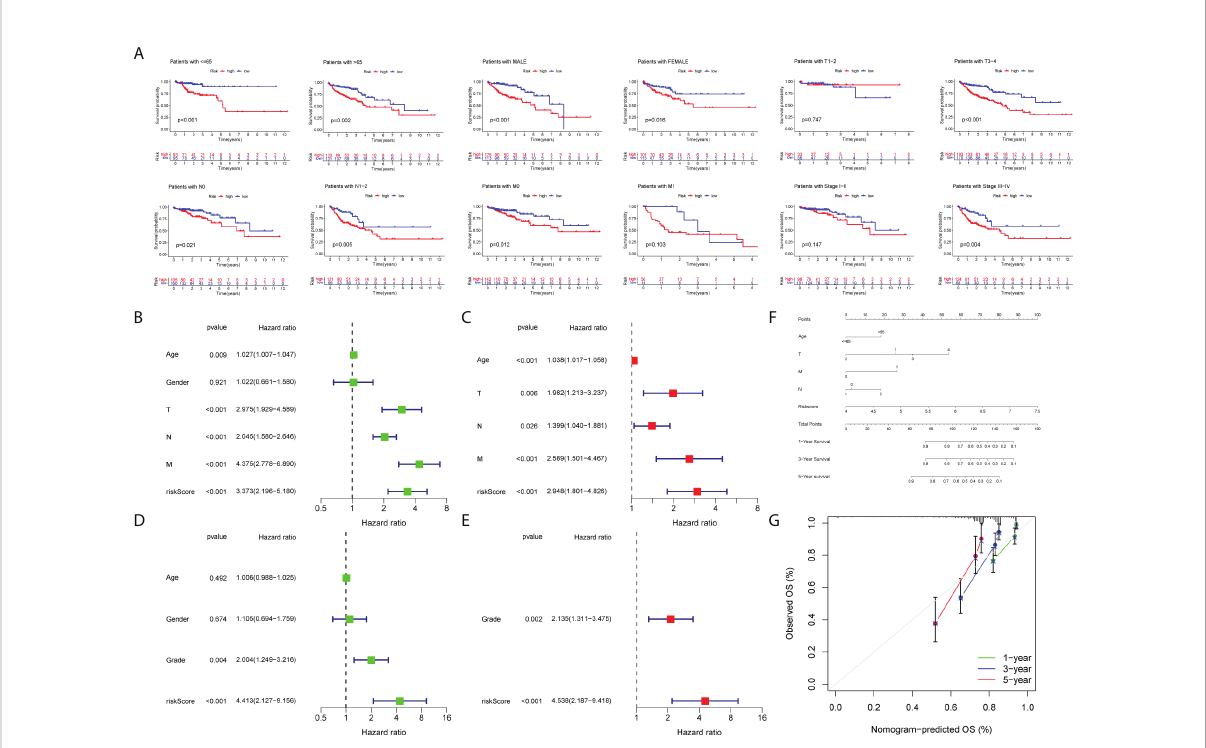
FIGURE 6 Survival analysis and construction of a nomogram. (A) Survival analysis in subgroups including gender, age, and tumor stages. Univariate Cox regression analysis revealing the association between patients ’ overall survival and clinicopathological parameters along with m7G-related lncRNA risk scores in the training set (B) and test set (D) . Multivariate Cox regression analysis uncovering independent prognostic factors in the training set (C) and test set (E) . (F) Nomogram depending on the m7G-related lncRNA risk score and other clinicopathologic feature predicting the 1-, 3-, and 5-year overall survival for COAD patients. (G) Calibration curves illustrating the consistency between predicted and observed 1-, 3-, and 5-year overall survival rates in COAD patients based on the